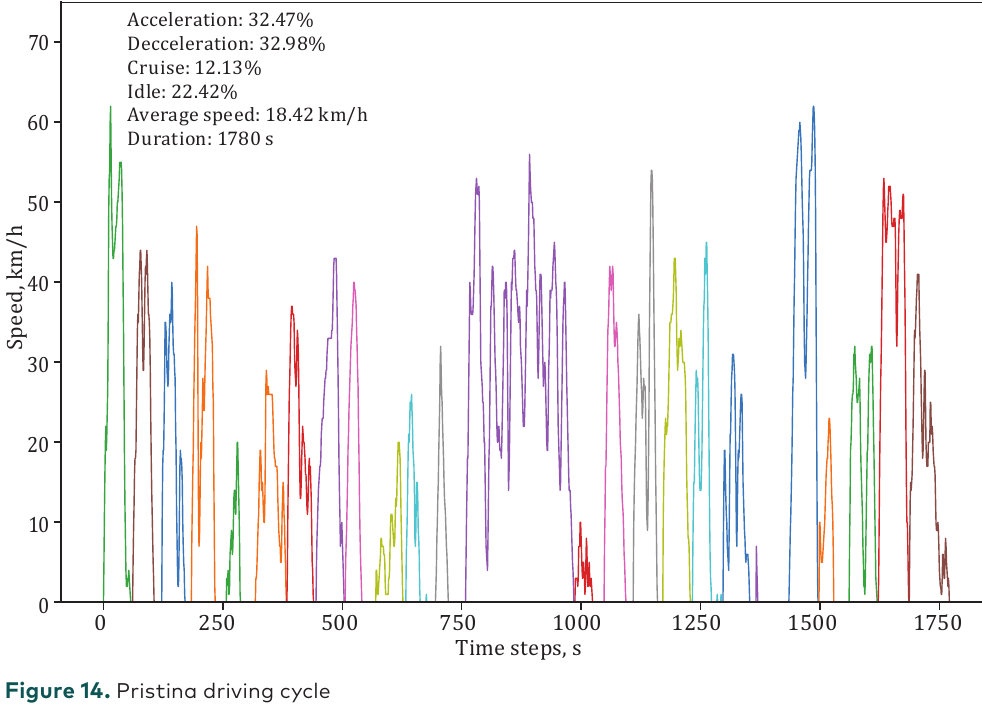
Figure 14. Pristina driving cycle